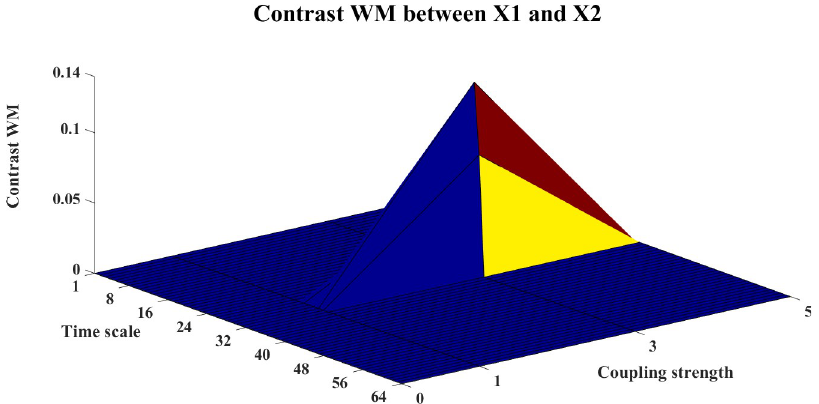
Fig 19. The contrast WM information transfer for X1 ! X2. The 3D surface presents the contrast WM information transfer ( O